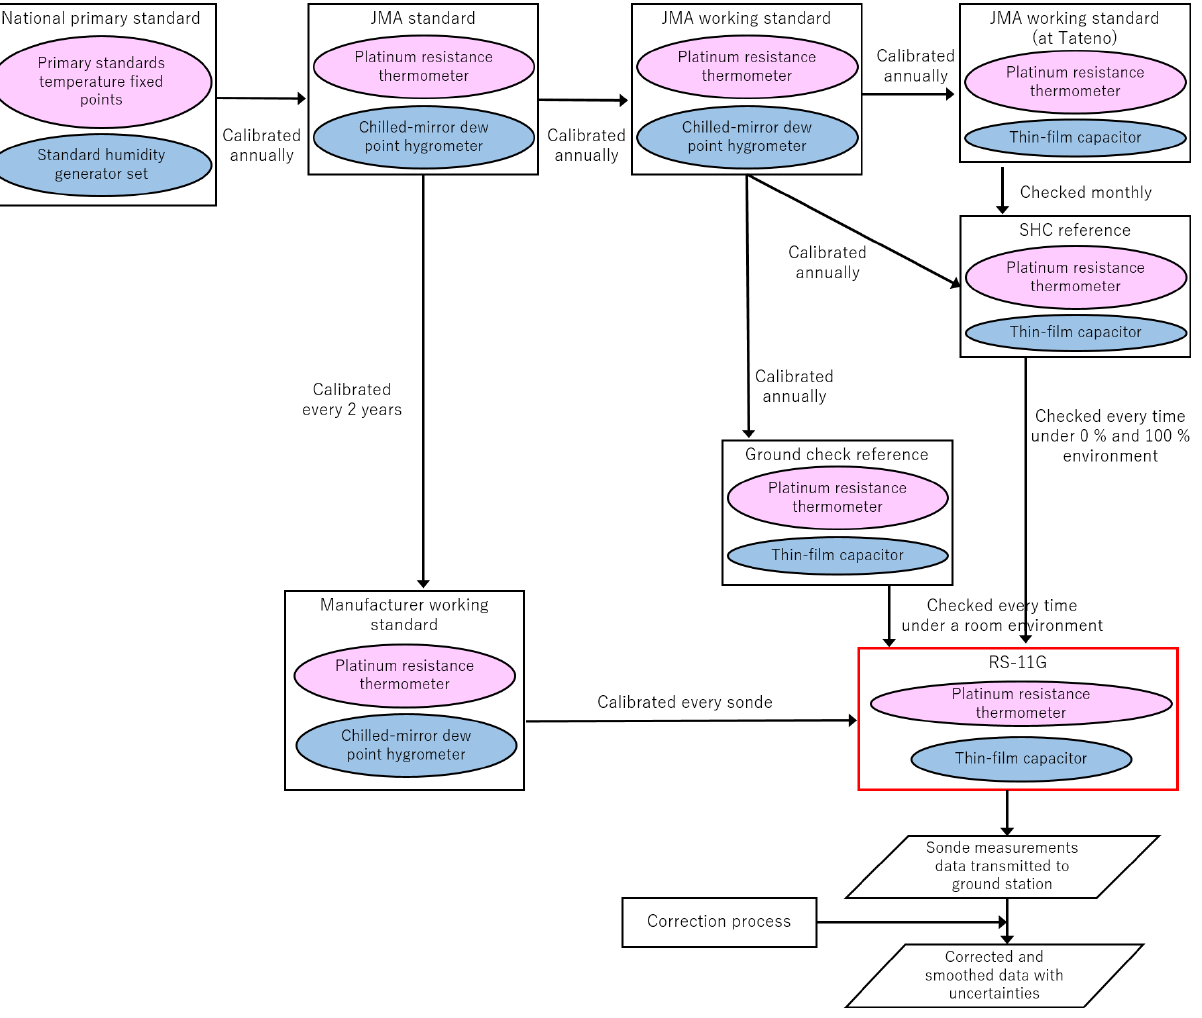
Figure 1. Traceability of the temperature and RH sensors on RS-11G. Pink and blue ellipses indicate temperature and RH sensors, respec- tively. Parallelograms indicate data. The details of the correction procedures are shown in Figs. 2–5. Further details of the traceability of the RS-11G sensors can be found in Sect. 5 of Kizu et al.